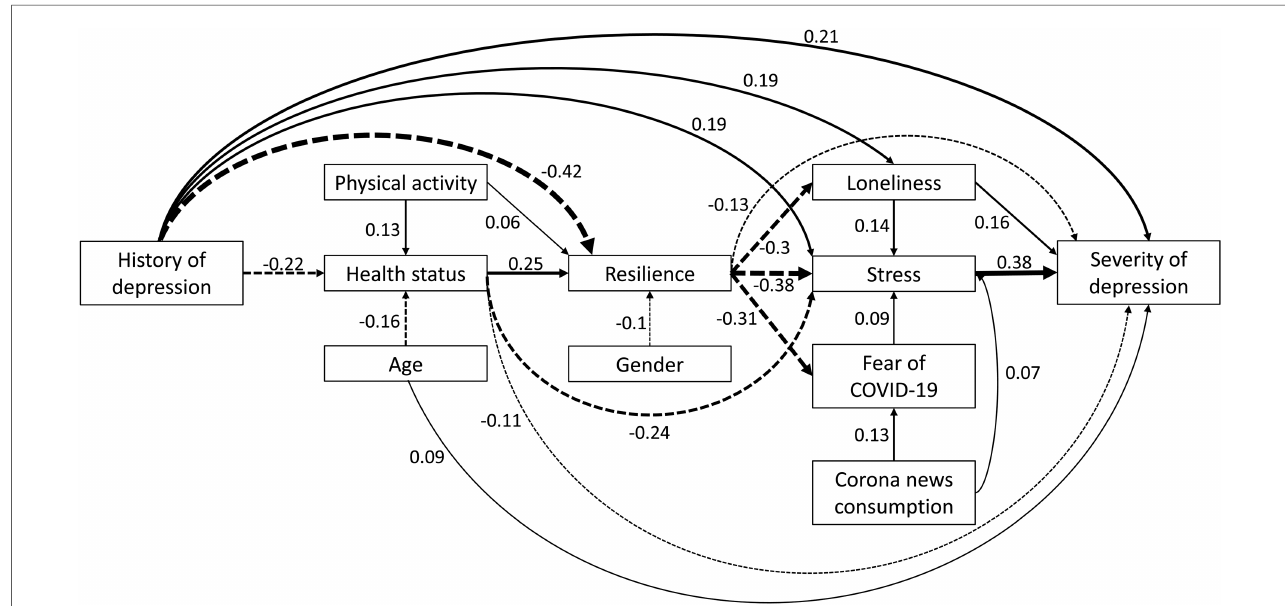
FIGURE 3 Path model of the severity of depression and relevant factors at the 3-month peri-pandemic timepoint. Numbers indicate standardized regression coef fi cients of the path model. Solid lines indicate positive effects and dashed lines negative effects. Line widths re fl ect effect sizes.